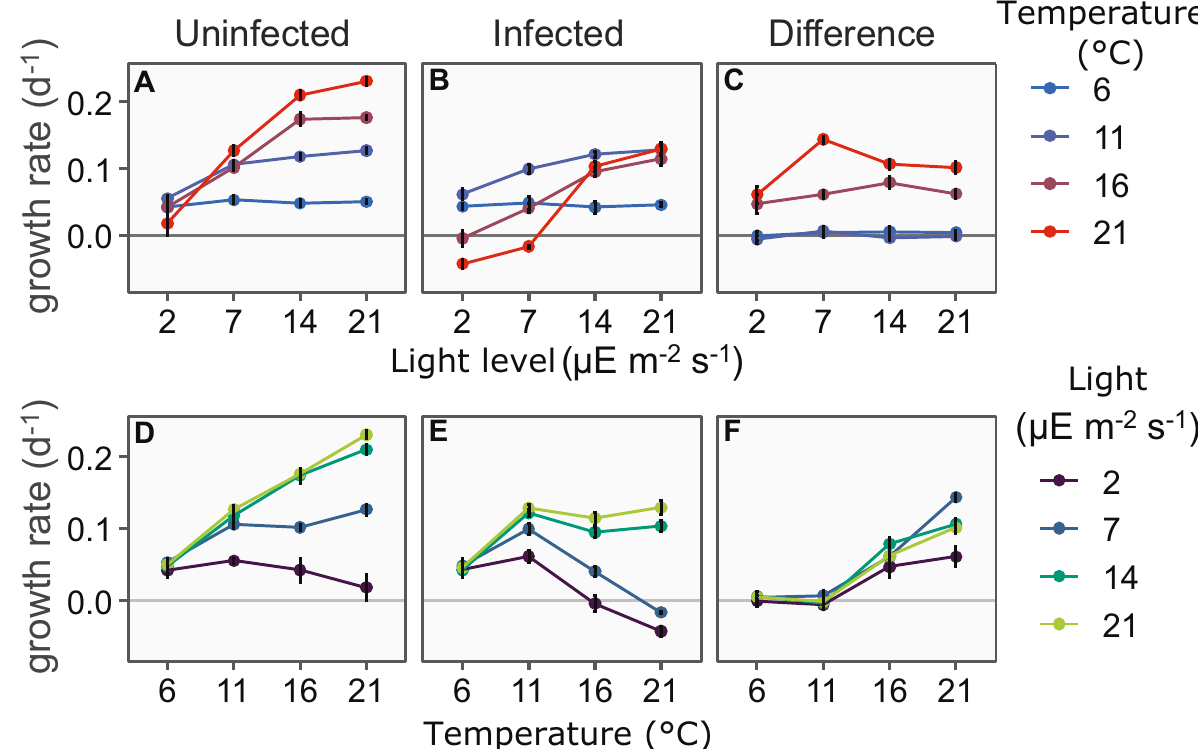
Fig. 1 Planktothrix growth rate varies strongly with temperature, light and infection status. A - C Growth rate of uninfected and infected P. rubescens as a function of light at each of the 4 temperatures tested. The effect of the interaction between light and temperature is clearly visible both in infected and uninfected treatments. Infection reduces growth rate at 16 and 21 °C but not at 6 and 11 °C. Within each temperature, changing light has little effect on the difference in growth rate between infected and uninfected treatments. D - F The same data, viewed with temperature on X-axis and with light levels indicated by color. Within each light level, changing temperature has a large effect on the difference in growth rate between infected and uninfected treatments. In all panels dots represent mean growth rates and error bars represent the standard error of the